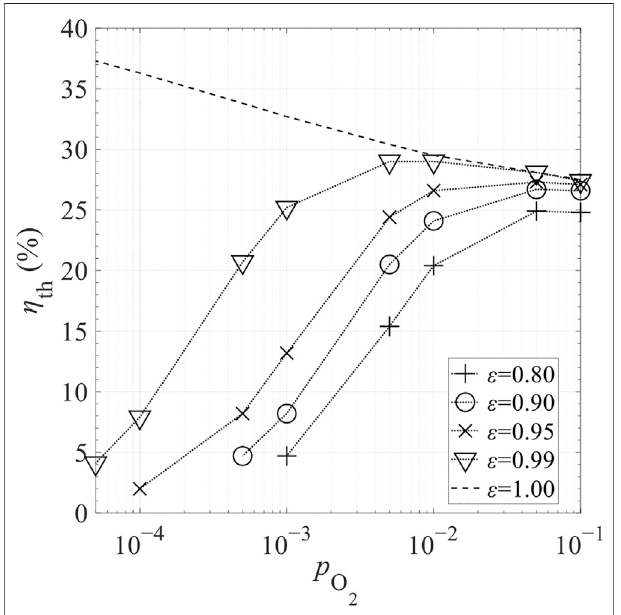
FIGURE 20 | Contours of total solar-to-fuel ef fi ciency, η th in different levels of non-dimensional reduction temperature, θ p , and relative oxygen partial pressure P p for ε (cid:2) 0.95 and C (cid:2)